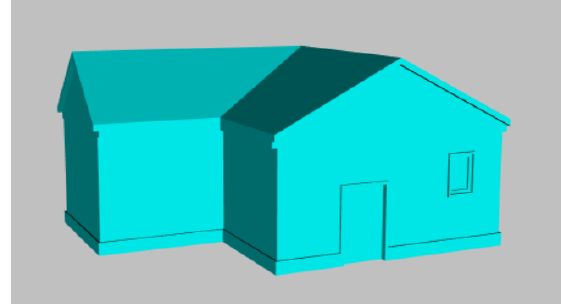
Figure 8 . The repaired 3D model